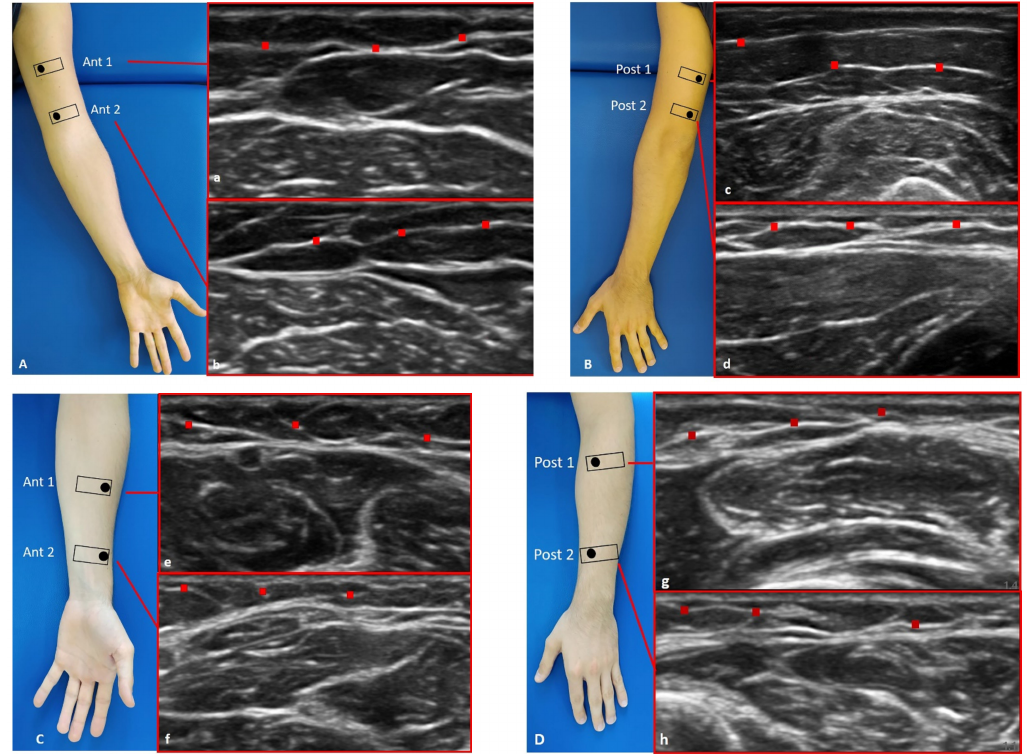
Figure 1. Ultrasound (US) images of the superficial fascia of: the anterior region of the arm ( A ) and of the forearm ( C ); the posterior region of the arm ( B ) and of the forearm ( D ). Anterior regions ( A , C ) at levels Ant 1 ( a , e ) and Ant 2 ( b , f ). Posterior regions ( B , D ) at levels Post 1 ( c , g ) and Post 2 ( d , h ). Probe: black rectangle. Red dashes: superficial fascia. Reprinted with permission from